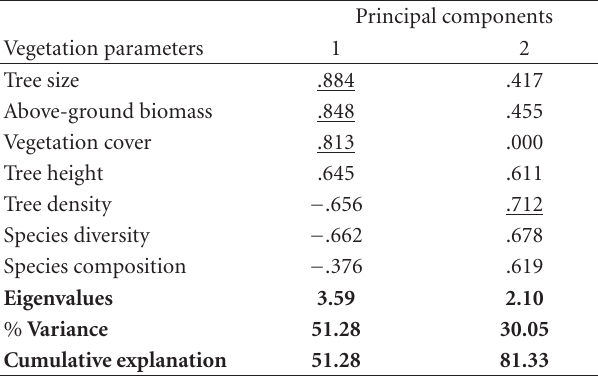
Table 1: Ordinary component matrix of vegetation parameters a